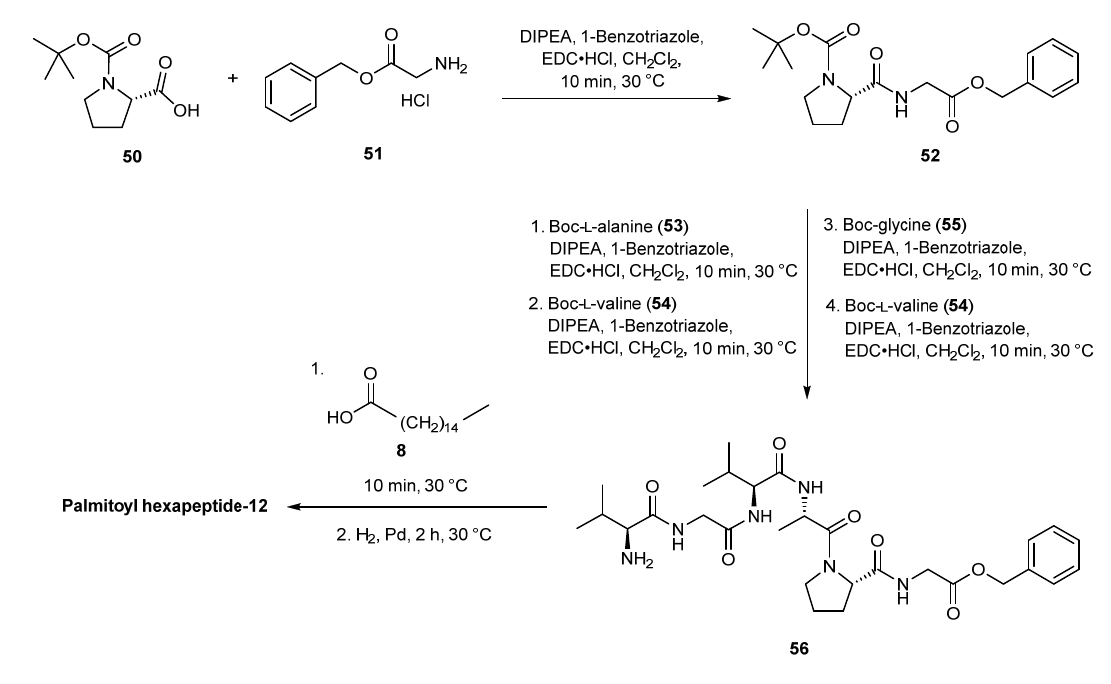
Scheme 9. Synthesis of palmitoyl hexapeptide-12. Adapted from [74]